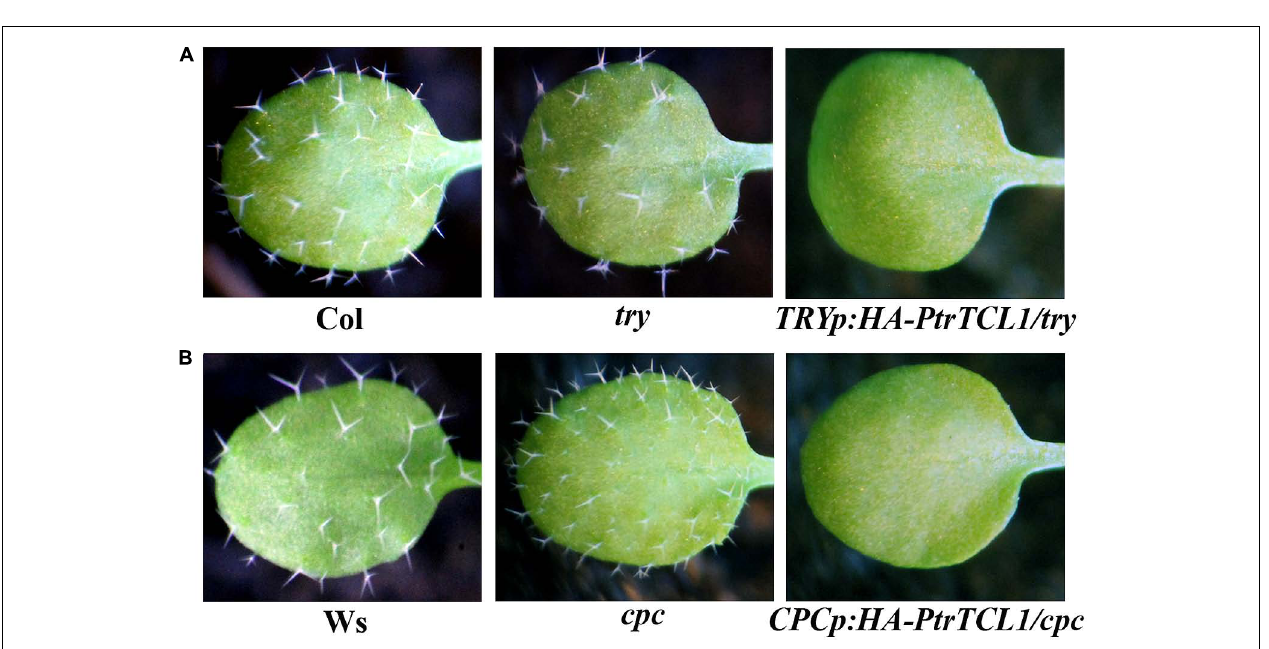
(B) Expression of PtrTCL1 under the control of CPC native promoter in the cpc mutant background resulted in glabrous phenotype. Pictures were taken from 2-week-old, soil-grown